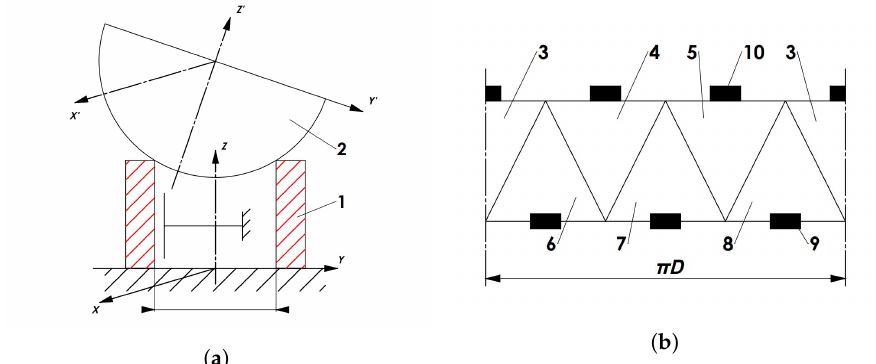
Figure 4. ( a ) Analyzed kinematic pair; ( b ) Proposed triangular electrode